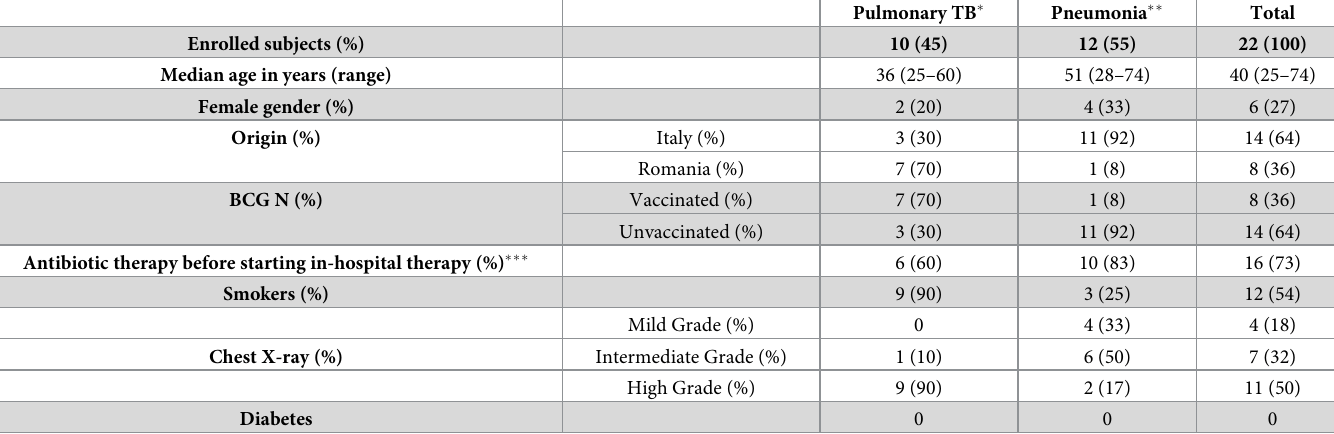
Table 4. Demographic characteristics of the subjects enrolled at the National Institute for Infectious Diseases in Rome, Italy.